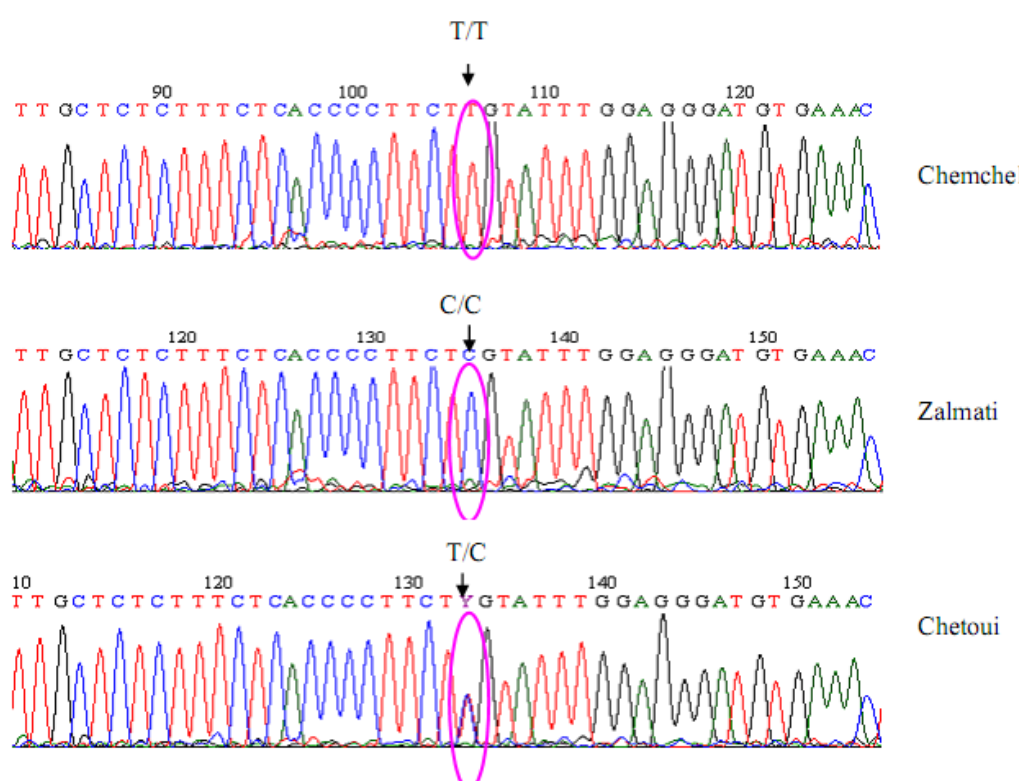
Figure 1. Example of sequence comparison using the program